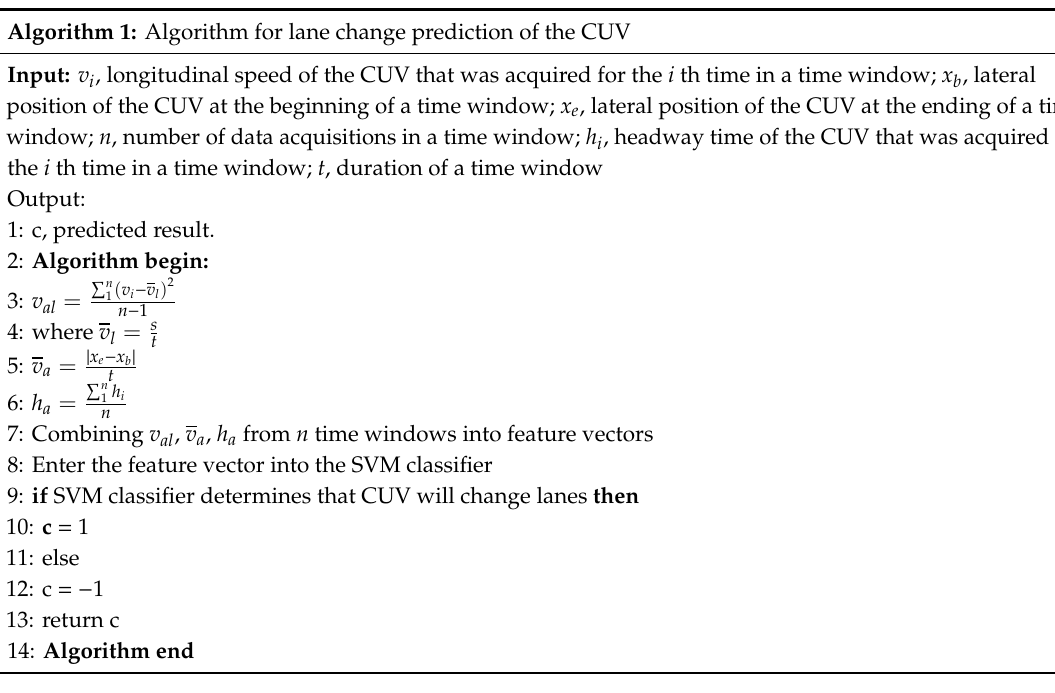
Algorithm 1: Algorithm for lane change prediction of the CUV